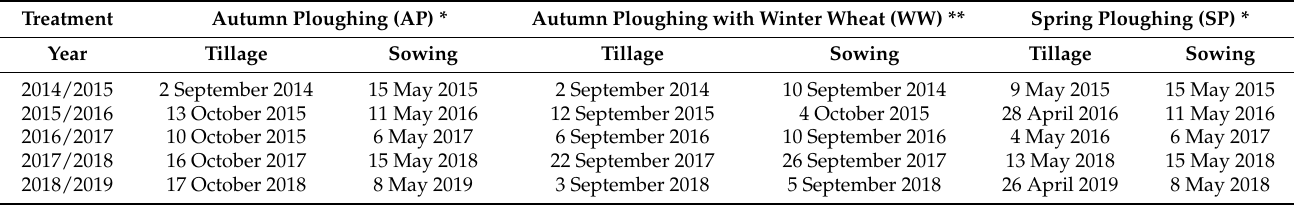
Table 2. Time of tillage and sowing for each of the three treatments in the five years (1 September–1 September).